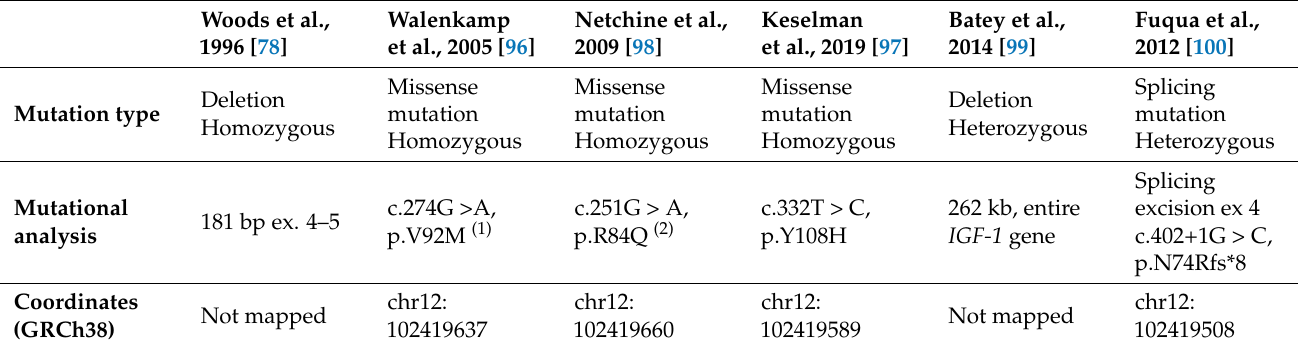
Table 1. Human IGF1 gene mutations associated with auditory functional